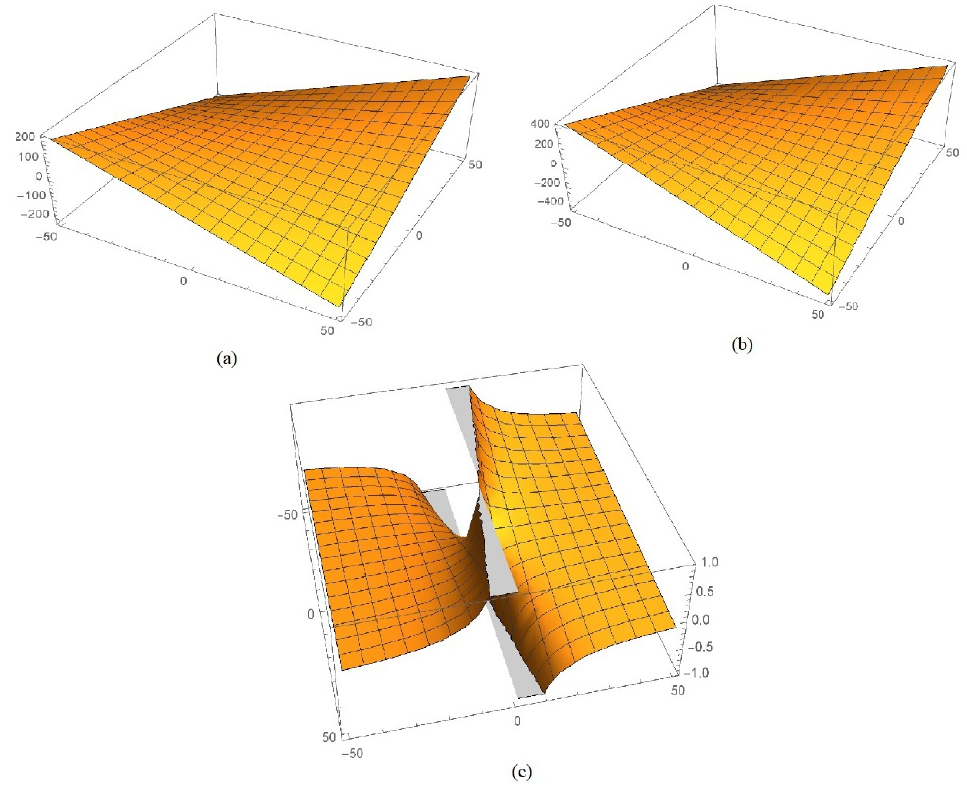
Figure 3. Three dimensional (3D) display of X ( ϕ , t ) for α = 0.5—( a ), α = 1—( b ) and for the exact solution—( c